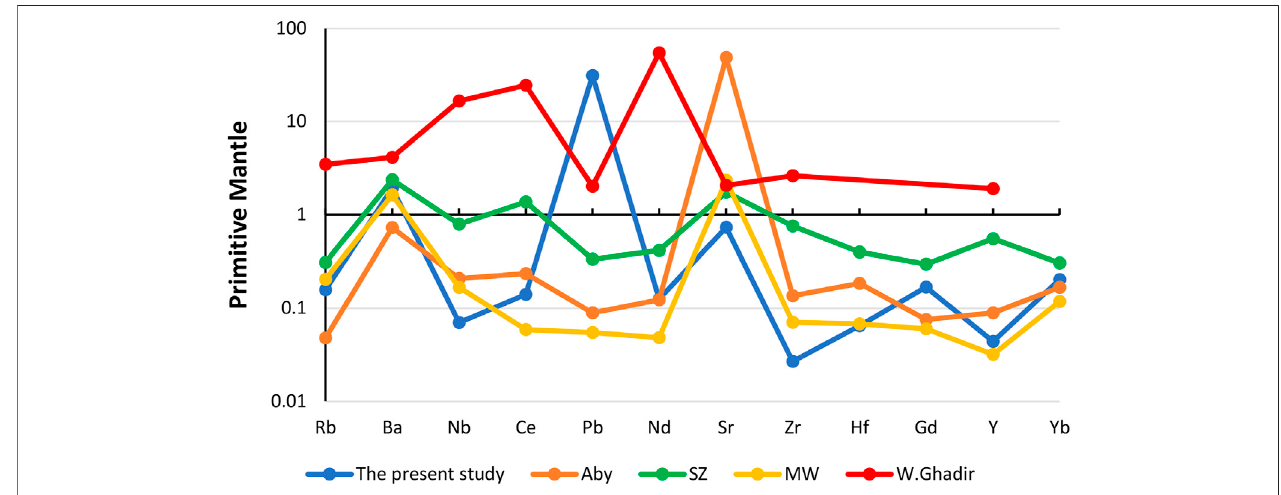
FIGURE 9 | Primitive mantle-normalized patterns (according to Sun and McDonough, 1989) of trace and REE in the studied serpentinites showing a comparison between the present studied, Wadi Ghadir after Surour (2017), and an average of abyssal, SZ and mantle wedge after Deschamps et al. (2013).